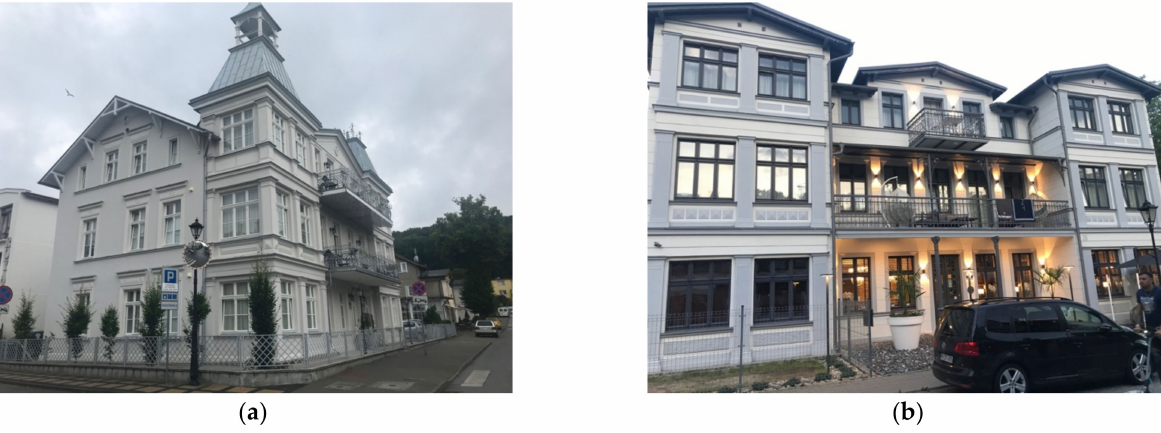
Figure 5. Point elements: Historic guesthouse buildings—facilities after adaptation and renovation: ( a ) guesthouse at Pomorska Street in Mi˛edzyzdroje), ( b ) guesthouse at Promenada in Mi˛edzyzdroje. Source: Author’s photo ( a , b